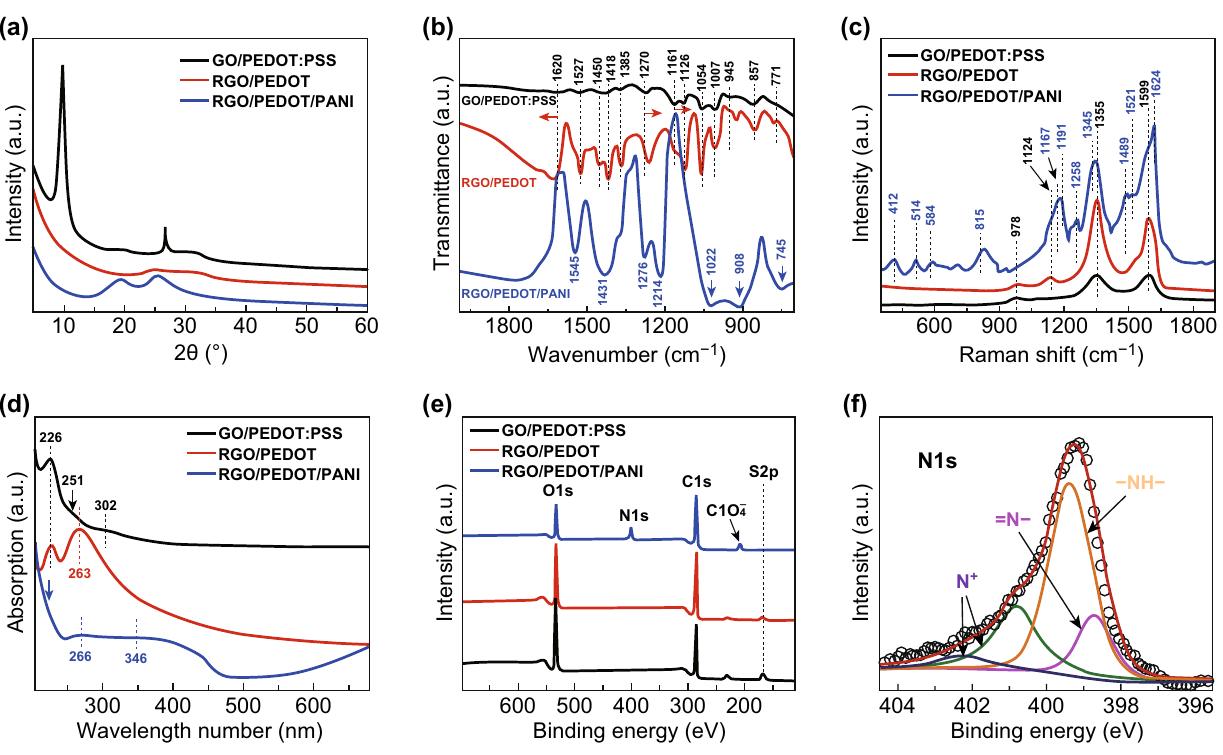
Fig. 4 a XRD patterns, b FTIR spectra, c Raman spectra, d UV–Vis spectra, e XPS full spectra of GO/PEDOT:PSS, RGO/PEDOT, and RGO/